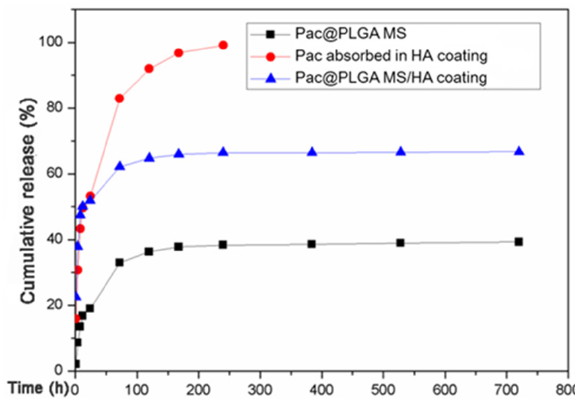
Figure 2. The vitro release of Pac-525 was detected through a cumulative release. Shown are the release curves of Pac-525 in PLGA microspheres, HA coating, and PLGA MS/HA coating.